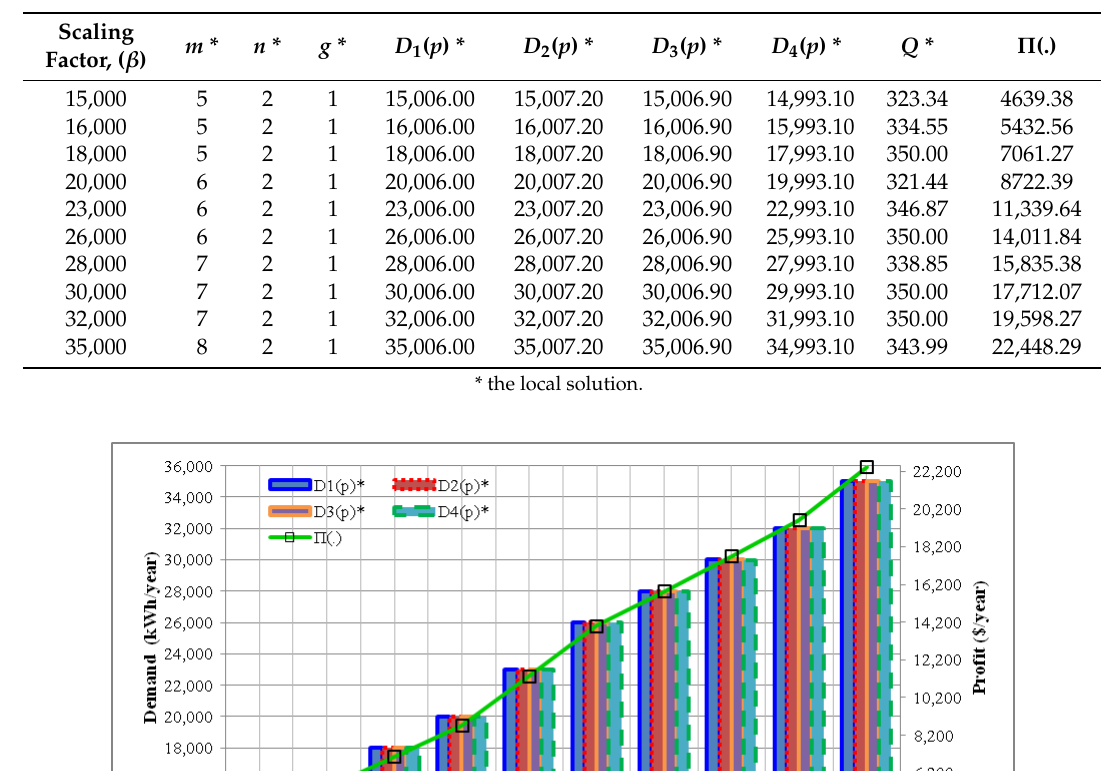
Table 7. Effect of Changes in the Scaling Factor Parameter.